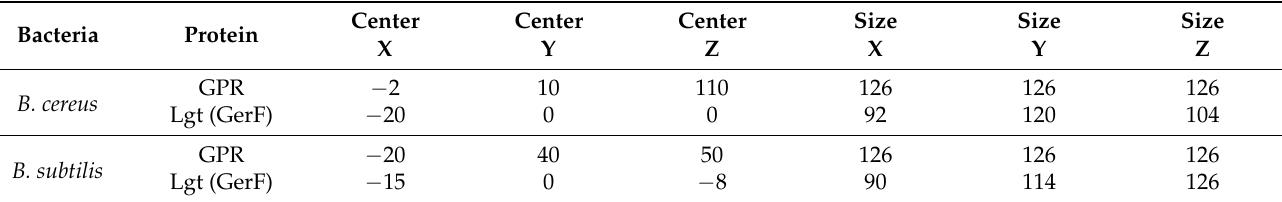
Table 7. Grid box information of conserved germination protein for binding